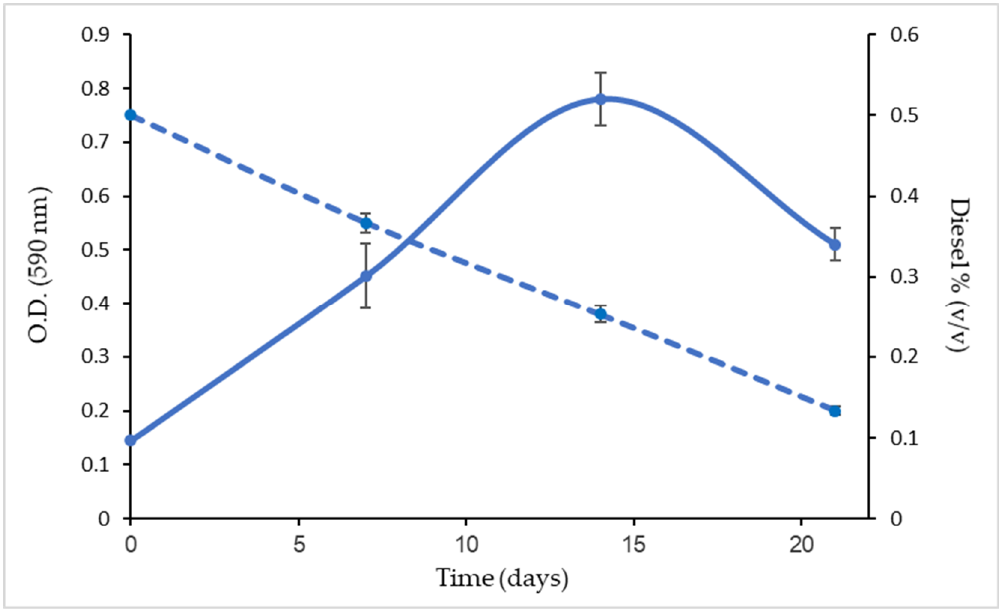
Figure 1. The obtained diesel-degrading consortium growth curve in mineral medium (MM) supplied with 0.5% (v/v) diesel (MMD).